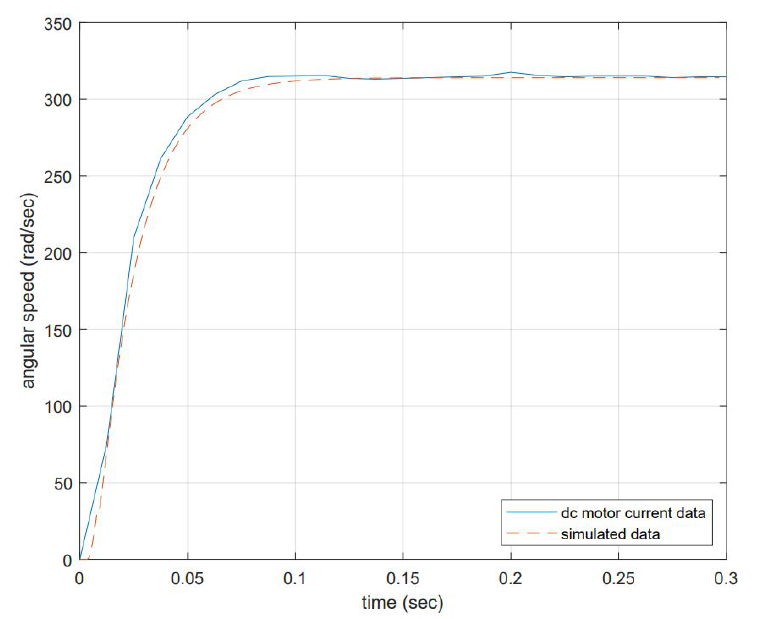
Figure 4. Open-loop system response to a voltage input of 12 volts. The angular speed produced is proportional to the input voltage and is equal to 314.16 rad/s. The dynamic response of the system achieves 63% of the reference angular velocity at 0.025 s, the steady state error at 0% is achieved after 0.15